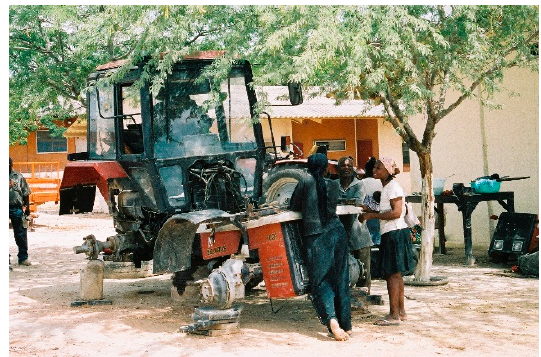
Figure 3. Public sector run machinery hire services face an insurmountable number of technical and administrative obstacles, which make them financially non-viable. (Photo: Brian Sims) .